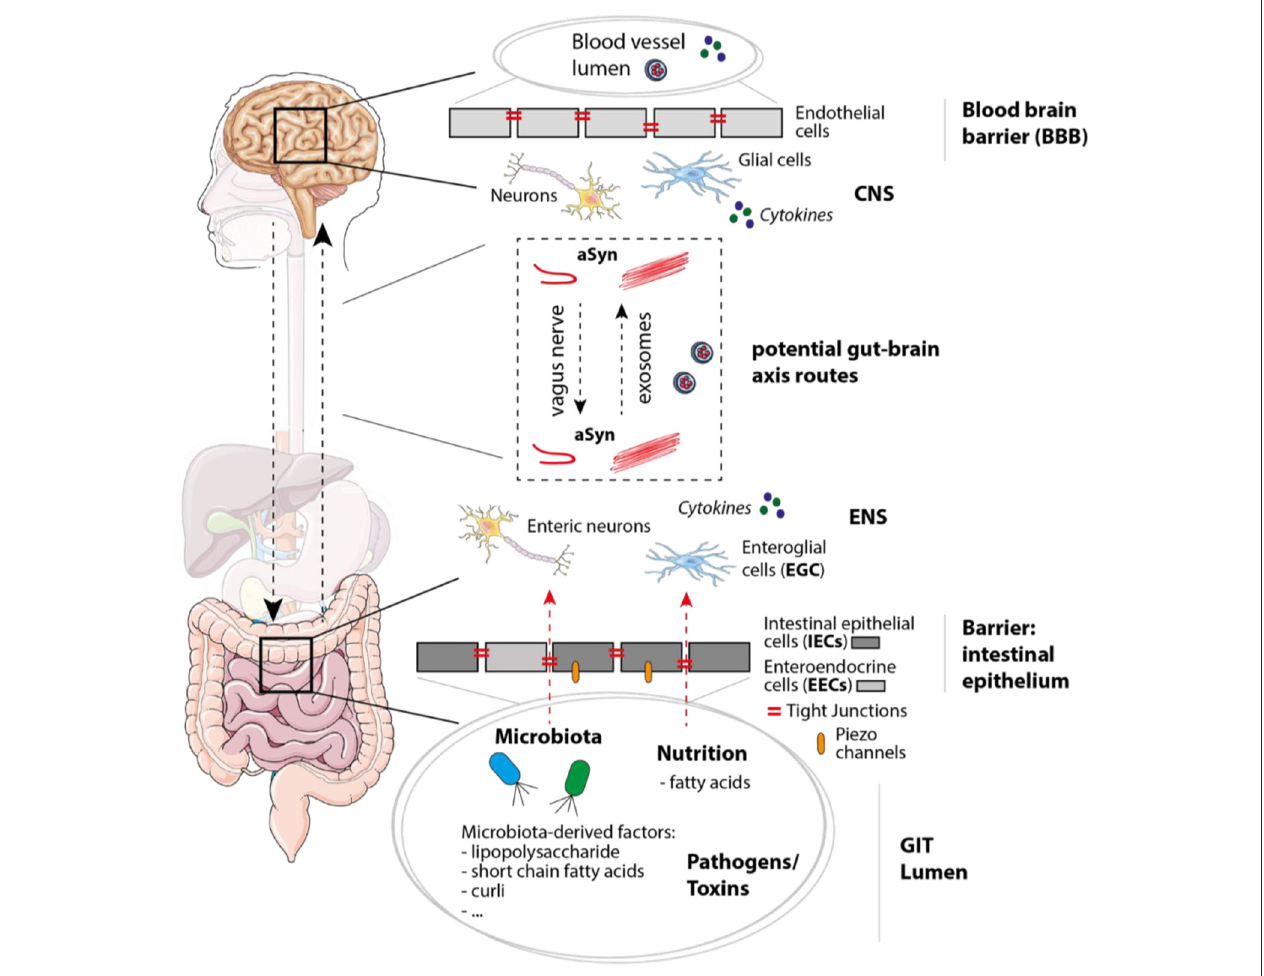
FIGURE 2 | Mechanisms, molecules, and cell types involved in PD/IBD pathology and gut-brain communication. In the gastrointestinal tract (GIT) the intestinal epithelium functions as barrier and separates the GIT lumen from the surrounding enteric nervous system (ENS), which not only contains enteric neurons, but also enteroglial cells. Within the GIT lumen microbiota and microbiota-derived factors like polysaccharides, short chain fatty acids, and curli (bacterial amyloid protein) can be found, but also nutritions, possible pathogens and toxins. When integrity of the intestinal epithelium consisting of epithelial cells including enteroendocrine cells (IECs and EECs) is disturbed, molecules within the GIT lumen get in contact with cells of the ENS. Tight junctions and Piezo channels have been shown to play an important role in mechanosensation, peristalsis, and intestinal barrier function. Within the brain, the blood-brain barrier (BBB) separates the CNS (including neurons and glial cells) from the blood vessel lumen. Potential gut-brain axis routes on which aSyn and molecules like cytokines could be transferred are for instance the vagus nerve or exosomes [via the blood stream or cerebrospinal fluid (CSF)]. The figure contains modified components of Servier Medical Art, licensed under the